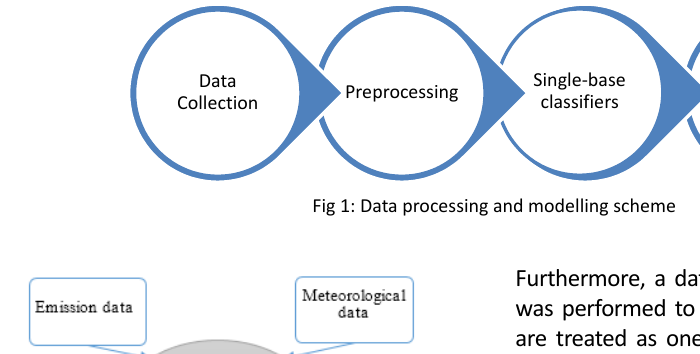
Fig 1: Data processing and modelling scheme